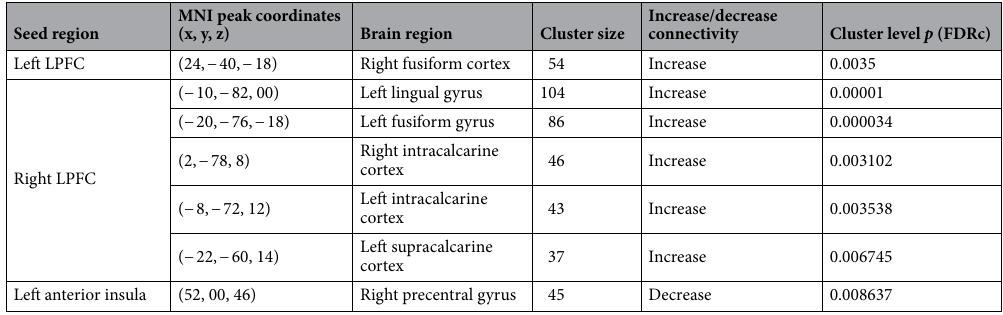
Table 4. Regressions predicting new onset of internalizing disorders adjusting for baseline internalizing symptoms. MNI Montreal Neurological Institute, FDR false discovery rate, LPFC lateral prefrontal